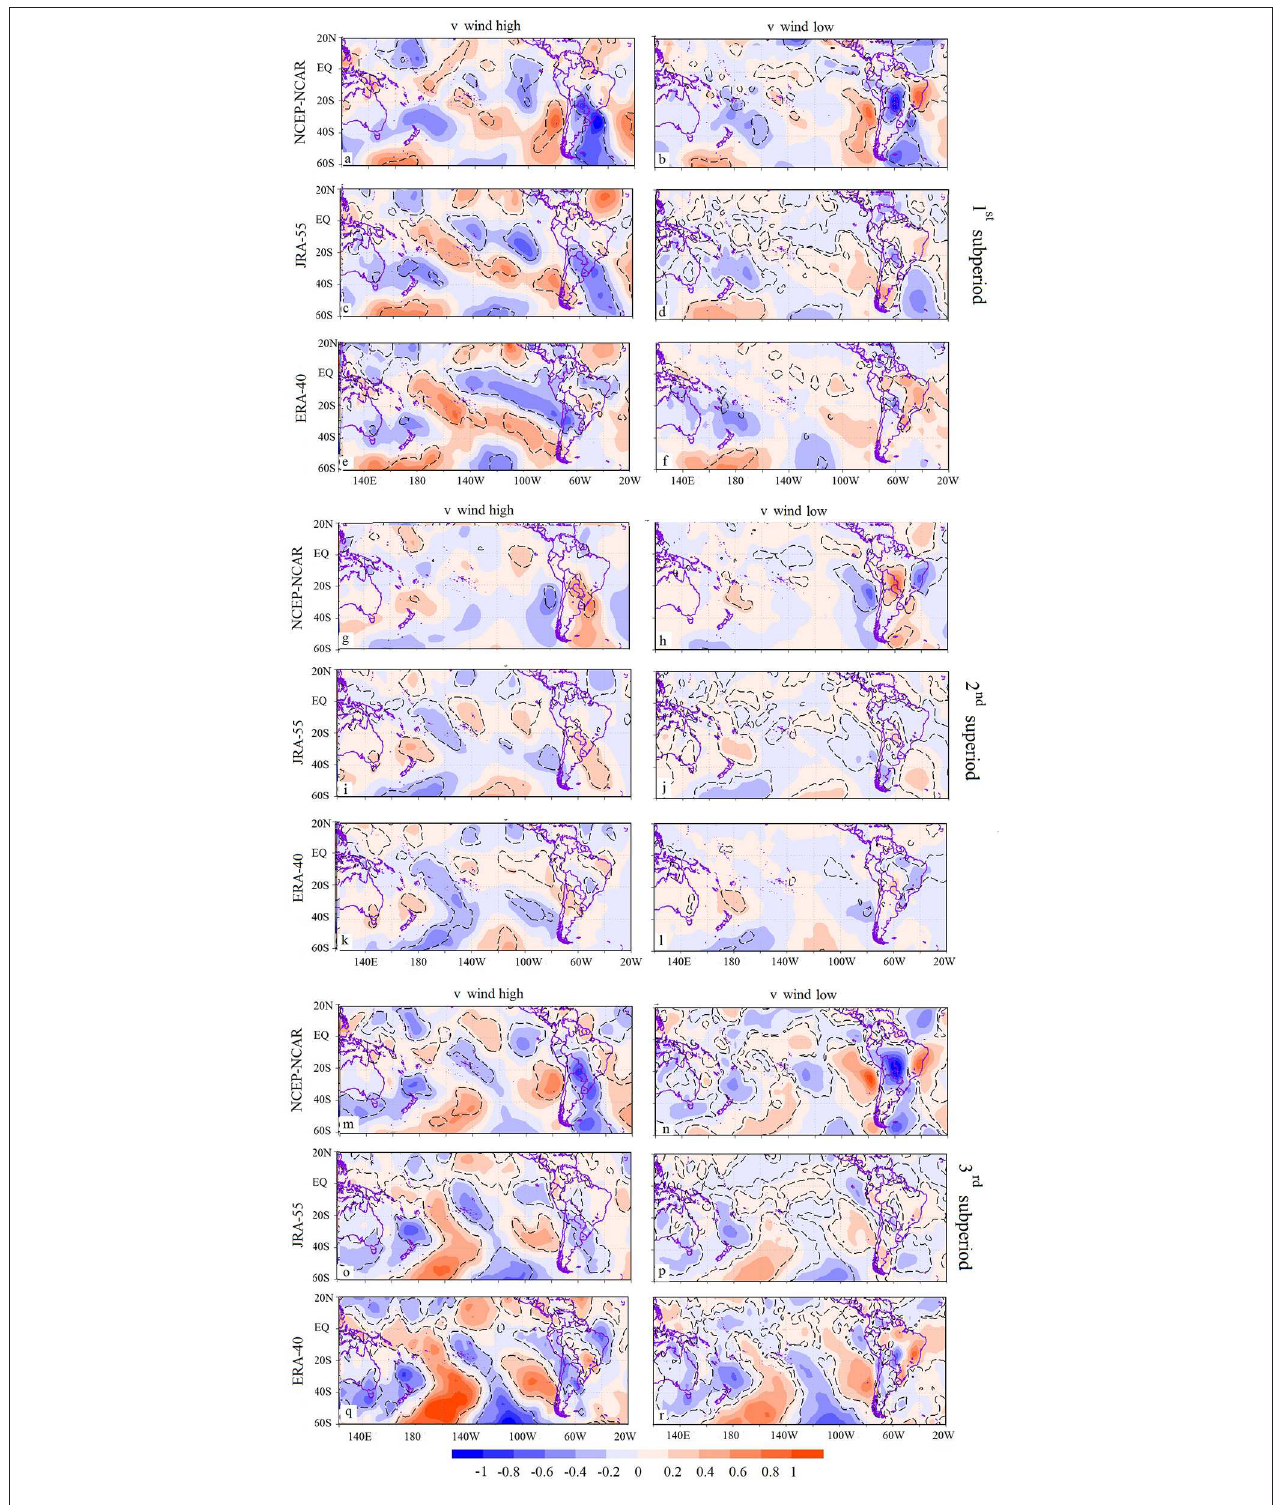
FIGURE 6 | Same as Figure 5 but for meridional wind anomaly.